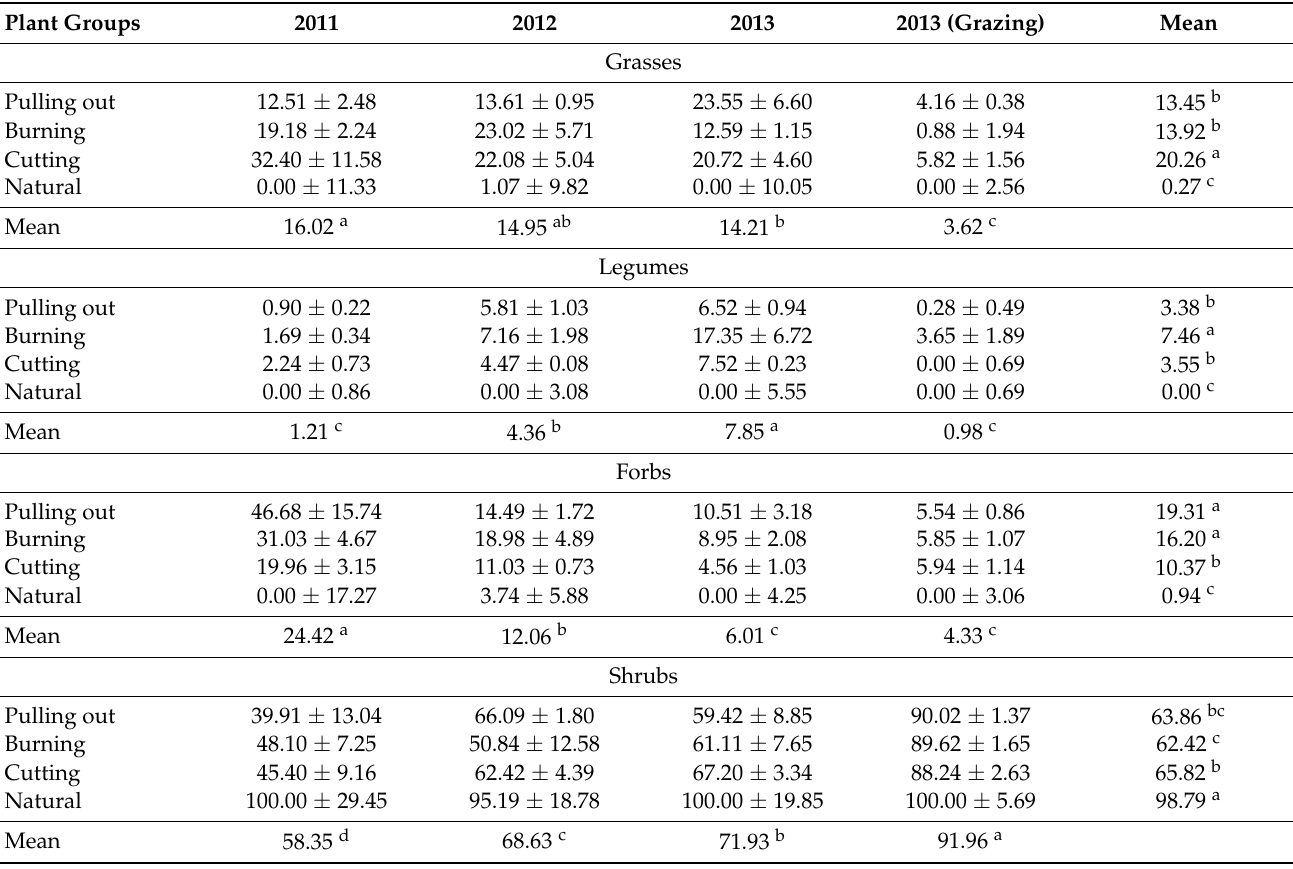
Table 1. Distribution of plant groups at improved and grazed rangeland levels according to year (% − x ± SD).